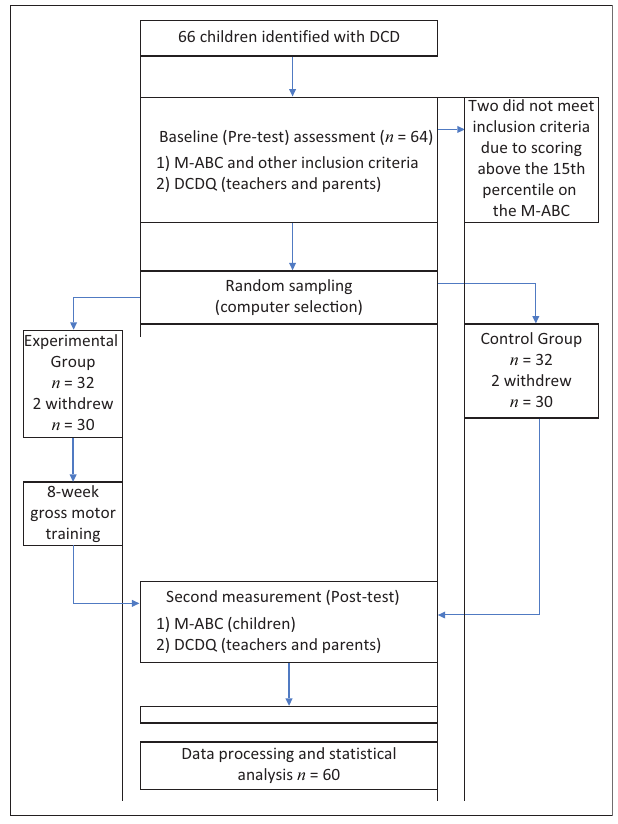
FIGURE 1: Flow diagram of